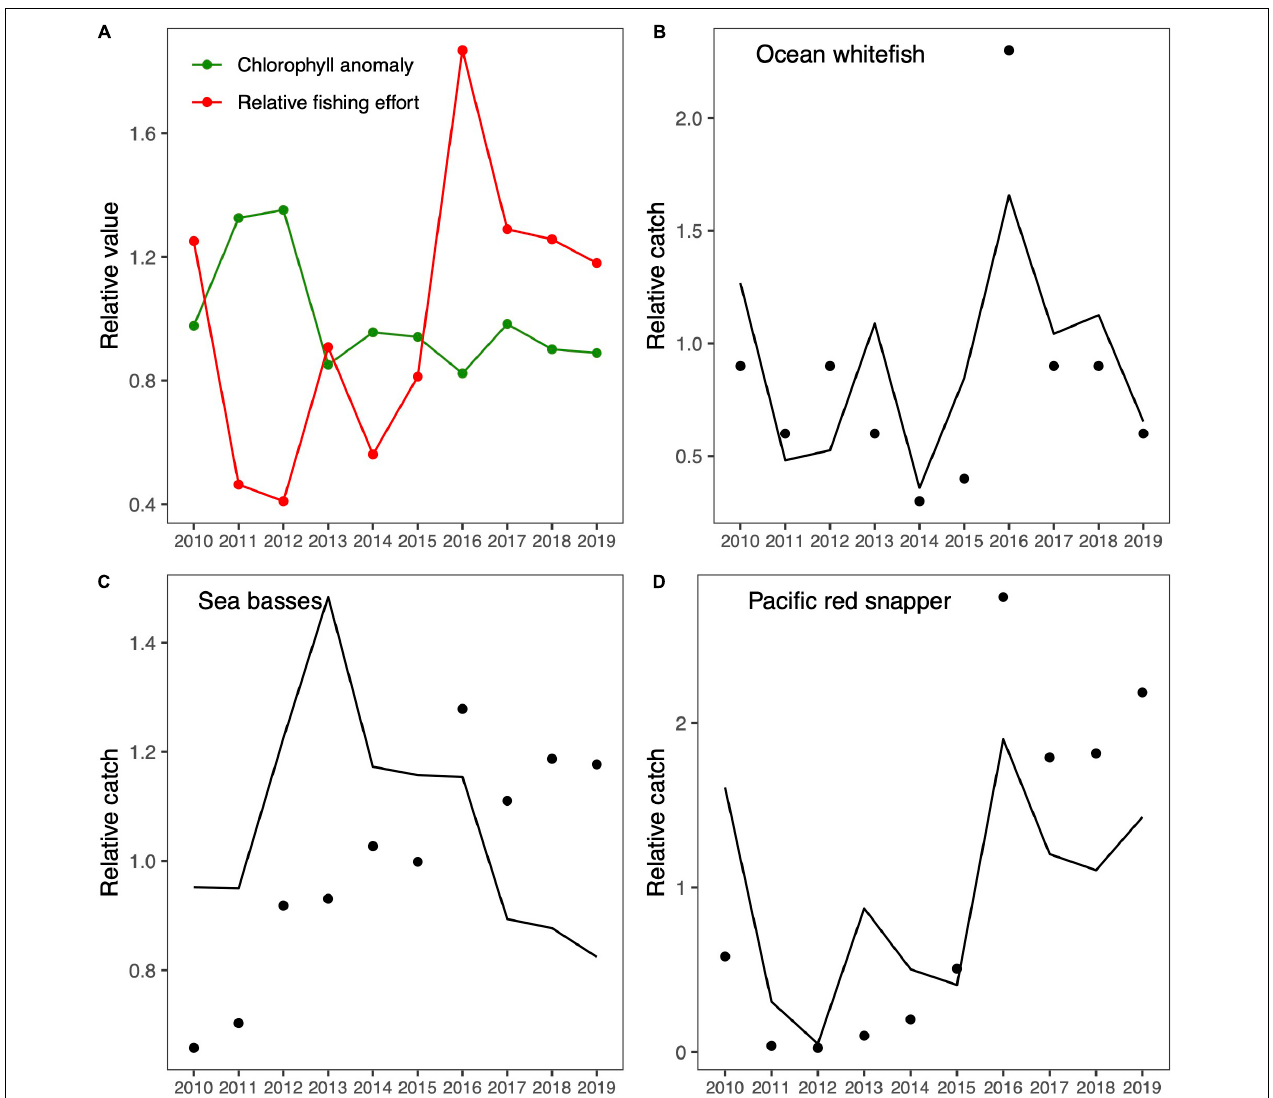
FIGURE 4 | Fitting of the Guaymas EwE model. (A) The forcing drivers, namely, satellite-derived chlorophyll-a anomaly and relative fishing effort, are shown in green and red, respectively. (B–D) The fitted trends of historical and predicted relative catches are shown by black dots and black lines,